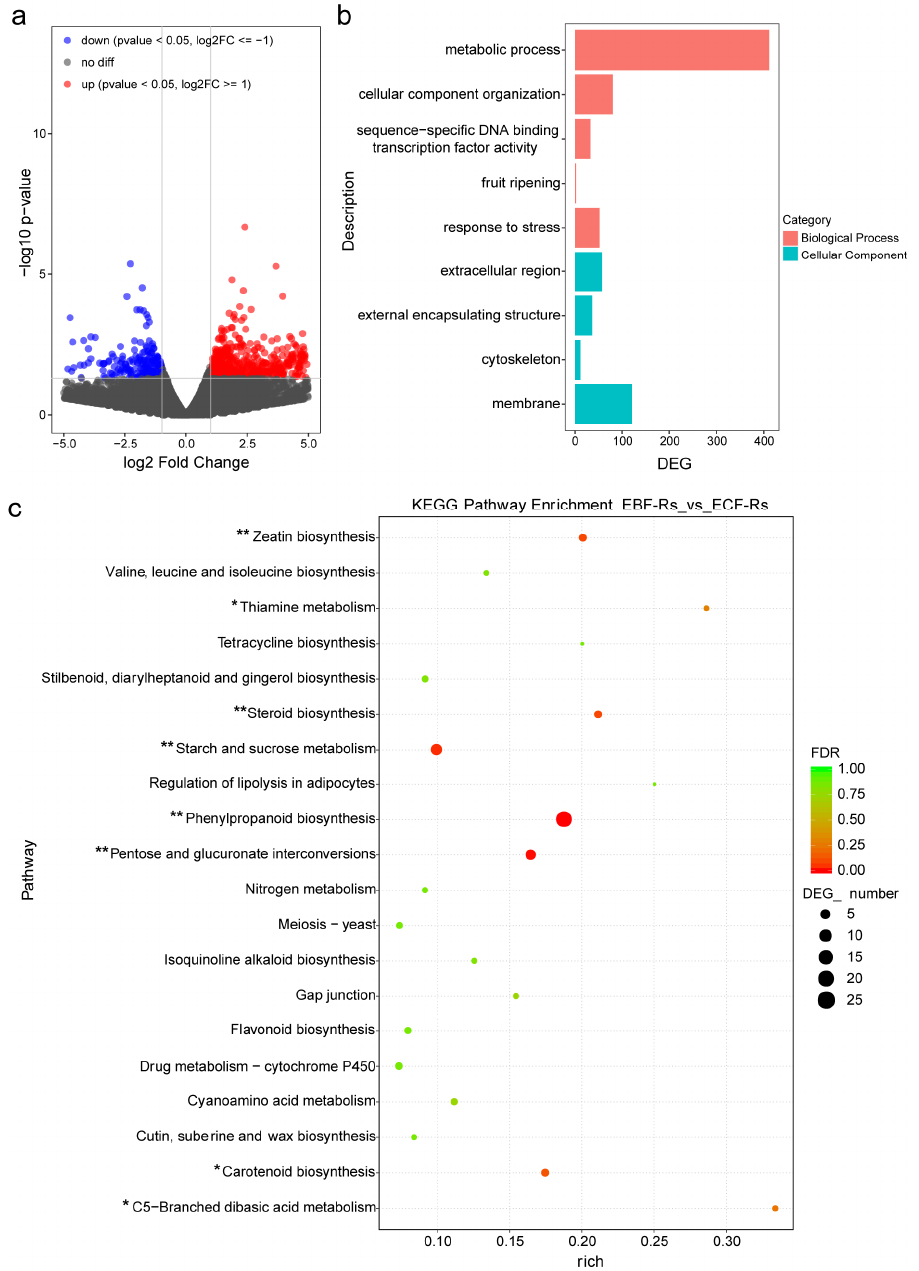
Figure 4. Transcriptome analysis of Experiment II. ( a ) Volcano diagram displaying the differentially expressed genes (DEGs, |log2fold-change| > 1.0 and p -value < 0.05); ( b ) Gene Ontology enrichment analysis (FDR ≤ 0.05); ( c ) KEGG pathway enrichment analysis (FDR ≤ 0.05). EBF-Rs: root derived from the BF soil and inoculated with R. solanacearum 7 days after the plant establishment in the split-root system; ECF-Rs: root derived from the CF soil and inoculated with R. solanacearum 7 days after the plant establishment in the split-root system. The asterisks indicate significant differences between treatments (* p < 0.05, ** p <